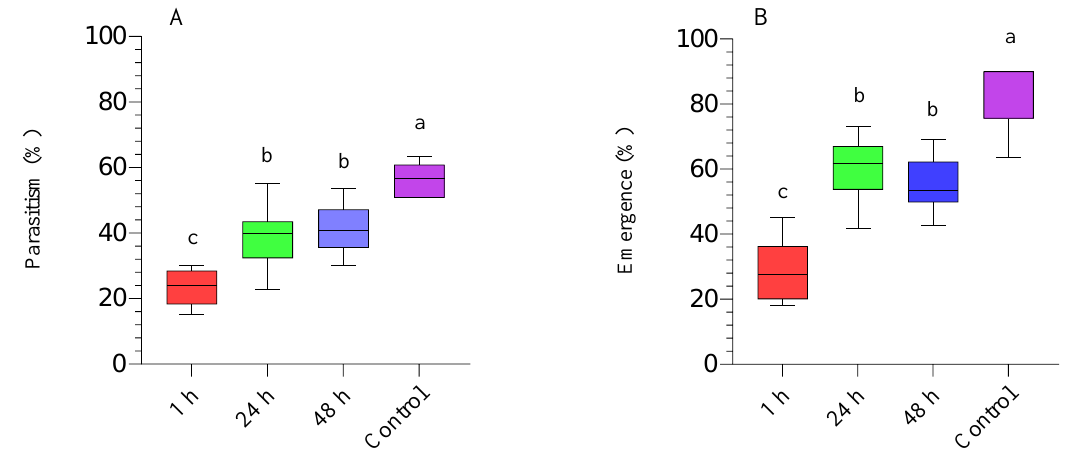
Figure 1. Percentage of parasitism ( A ) and emergence ( B ) of Tamarixia radiata from nymphs where Diaphorina citri nymphs were first parasitized by Tamarixia radiata and subsequently treated with Beauveria bassiana (BB-12) at 1, 24, and 48 h after parasitism. Means followed by the same letter are not significantly different (Tukey, p < 0.05).